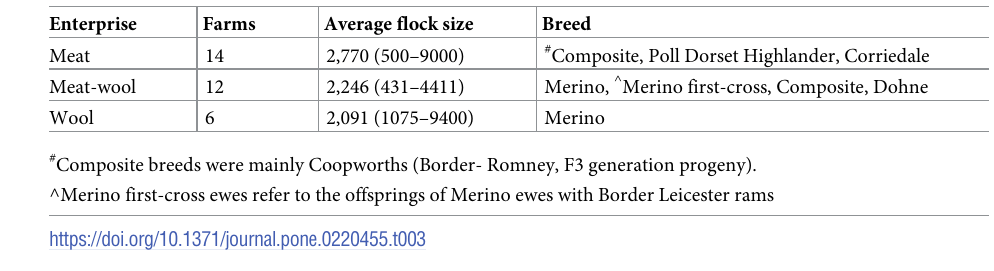
Labour units averaged 1.7 Full-time employees (FTE) and ranged between 0.5 to 3.5 FTE. The quality of the yards also varied significantly with an average score of 4.5 ( ± 1.8, n = 32) and ranged from 1 to 7. Results disclosed that yards , hectares , flock size and sheep : labour ratio